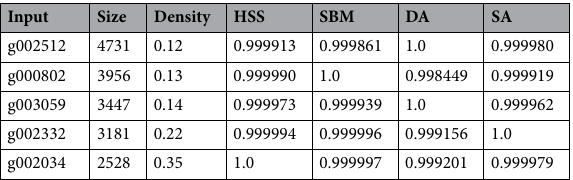
Table 5. Results for medium and medium classes, same as Table 1.